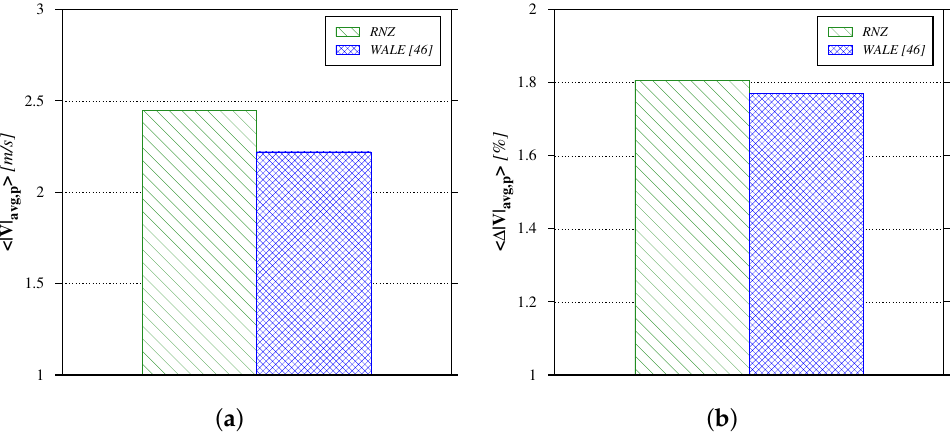
Figure 16. Statistical analysis of the | V | avg peak value over 20 consecutive cycles: ( a ) cycle-averaged peak value; ( b ) cycle-averaged percentage deviation of the peak